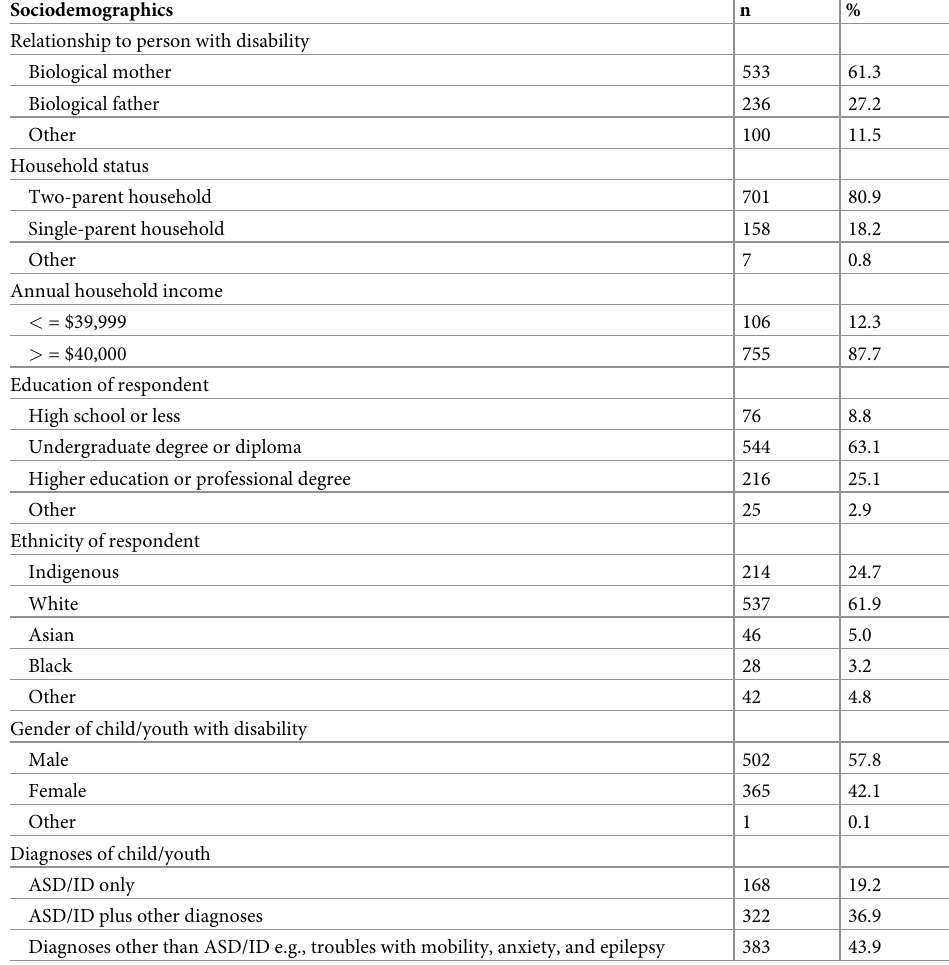
Table 1. Demographics of the survey respondents ( n =